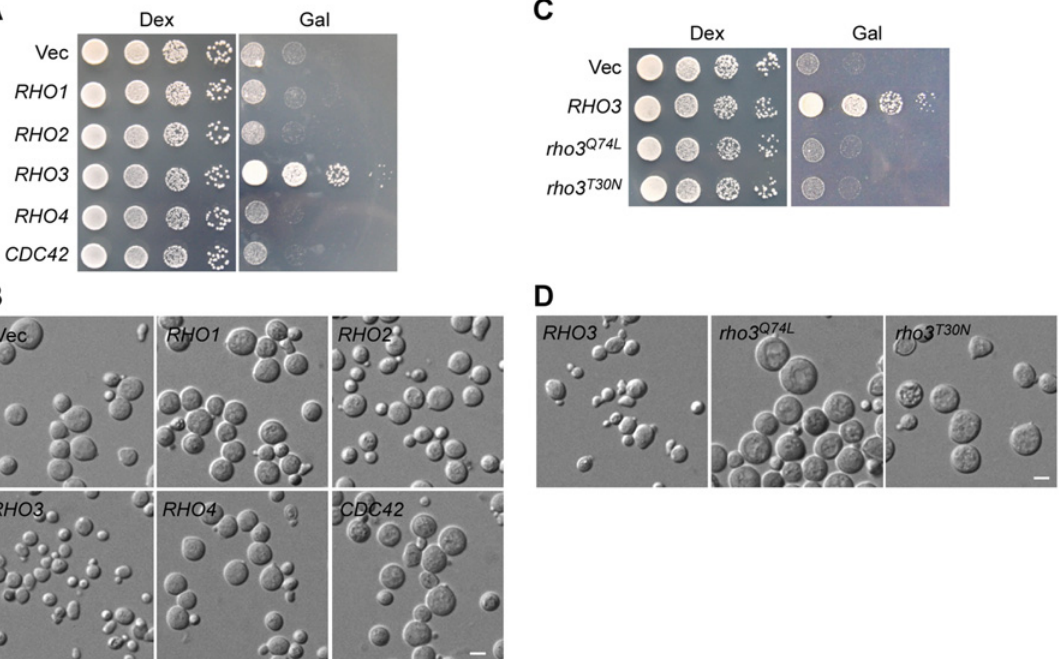
Fig 4. Rho3 suppresses the defect of Rga1-C538 overexpression. (A) YEF473A cells carrying integrated pEGKT305-RGA1-C538 overexpression plasmid along with replicative YEp24 (Vec), YEp24-RHO1, YEp24-RHO2, YEp24-RHO3, pRS426-RHO4, and YEp24-CDC42 were grown on SC-Leu-Ura (Dex) and SRG-Leu-Ura (Gal) plates at 30°C. Pictures were taken after 4 days. (B) DIC images of cells as in (A) grown on SRG-Leu-Ura plate for 20 hr at 30°C. (C) YEF473A cells carrying pEGKT305-RGA1-C538 along with pRS426 (Vec), pRS426-RHO3, pRS426-RHO3 Q74L , and pRS426-RHO3 T30N were grown on SC-Leu-Ura (Dex) and SRG-Leu-Ura (Gal) plates at 30°C. Pictures were taken after 4 days. (D) DIC images of cells as in (C) grown on SRG-Leu- Ura plate for 20 hr at 30°C. Bars, 5 μ